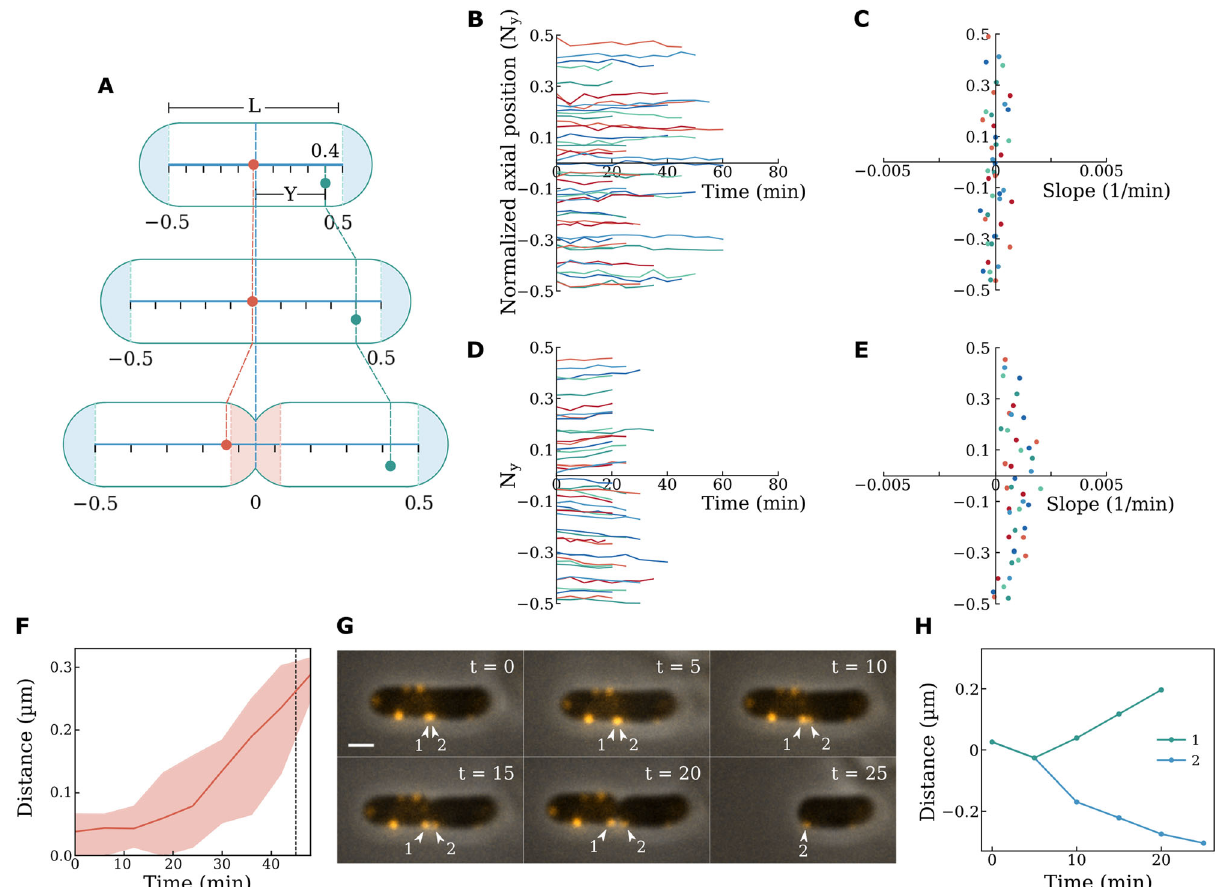
Fig. 3 Tracing the movement of BFMs in the normalized coordinate. A A schematic showing changes in the positions of BFMs during cell elongation and division in the normalized coordinate. B N y vs. time of BFMs in the normalized coordinate during cell elongation. All BFMs stayed in the same normalized positions, n = 44 (total number of tracked fl agellar motors). C Slopes of N y vs. time during cell elongation [data from ( B )]. D N y vs. time of BFMs in the normalized coordinate at the beginning of cell division. BFMs moved away from the center of the cell, revealing the formation of a septum (new inert zones), n = 44 (total number of tracked fl agellar motors). E Slopes of N y vs. time at the beginning of cell division [data from ( D )]. F Direct tracking of BFMs that were initially present near the center of the cell. The red line shows the average distance and the shaded area covers the upper and lower limits of the data. The dashed line indicates the division time points, n = 6 (total number of tracked fl agellar motors). The light color area represents the range of the data. G Two BFMs that were initially in close proximity at the center of the cell moved into two separate daughter cells after division. (Scale bar, 1 μ m). At least 3 times of the same experiment was repeated with similar results. H Trajectories of the two BFMs shown in G